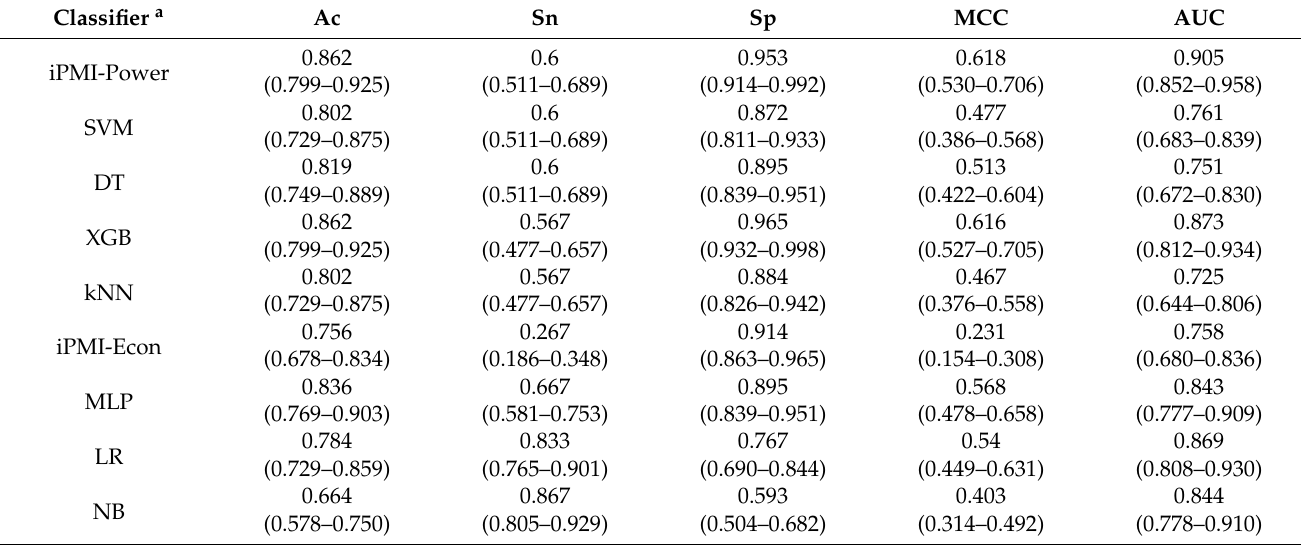
Table 3. Independent dataset testing results of the proposed iPMI and other well-known ML-based classifiers.